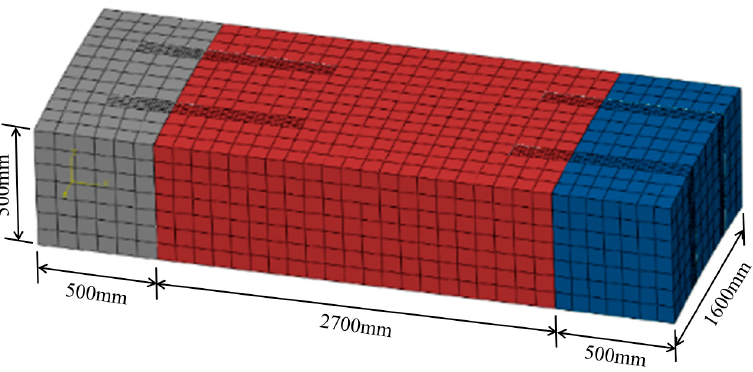
Figure 11. Verified numerical model.